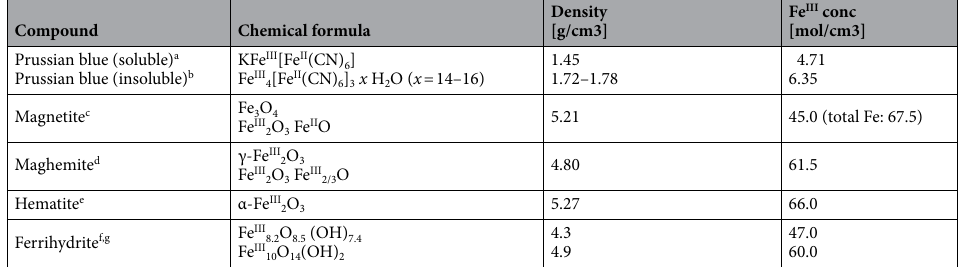
Table 1. Ferric iron content in Prussian blue in relation to other iron-oxide minerals and iron-oxyhydroxides found in tissues, as calculated from chemical formulae and volumetric mass density. a Keggin & Miles 1936 49 , b Buser et al. 1977 50 ; c,d Magnetite and its fully oxidized form, maghemite, are strongly ferrimagnetic minerals. The oxidation of magnetite to maghemite produces one vacancy at every third of the former iron(II) sites in the lattice, hence the lower density compared to magnetite. To emphasize the relationship between maghemite and magnetite, the chemical formula of maghemite can also be written as Fe III 2 O 3 Fe III 2/3 O or in sum, Fe 8/3 O 4 . e,f,g Hematite and ferrihydrite (for structural details see Michel et al. 2007, 2010 54,55 ) are weakly ferrimagnetic minerals. In the biological iron storage protein ferritin, iron is typically stored in the form of a nanocrystalline core of ferrihydrite or hematite, sometimes of a magnetite-like phase (magnetite or maghemite), at least in human brains 56 . Magnetic data of horse spleen ferritin can be explained by a combination of ferrihydrite and a variable but small amount of strongly magnetic phase like magnetite or maghemite 57